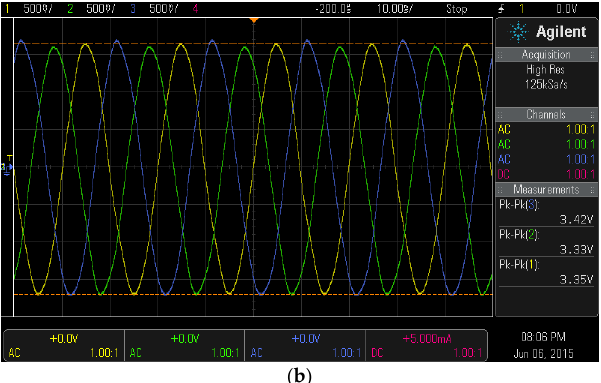
Figure 13. Output voltage waveforms ( i.e. , V a , V b , and V c ) of the three-phase inverter with R load for ( a ) simulation and ( b ) experimental.